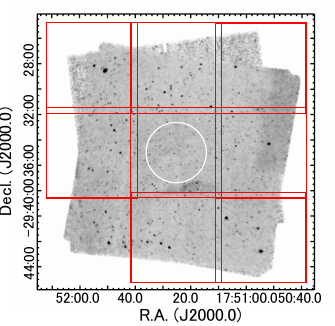
Figure 1: Smoothed and exposure-corrected X-ray im- age of the CBF (0.5–8 keV). The field of view of the SIRIUS (NIR) observations are shown by red squares. The white circle shows the region, the result of which was published in Revnivtsev et al (2009).